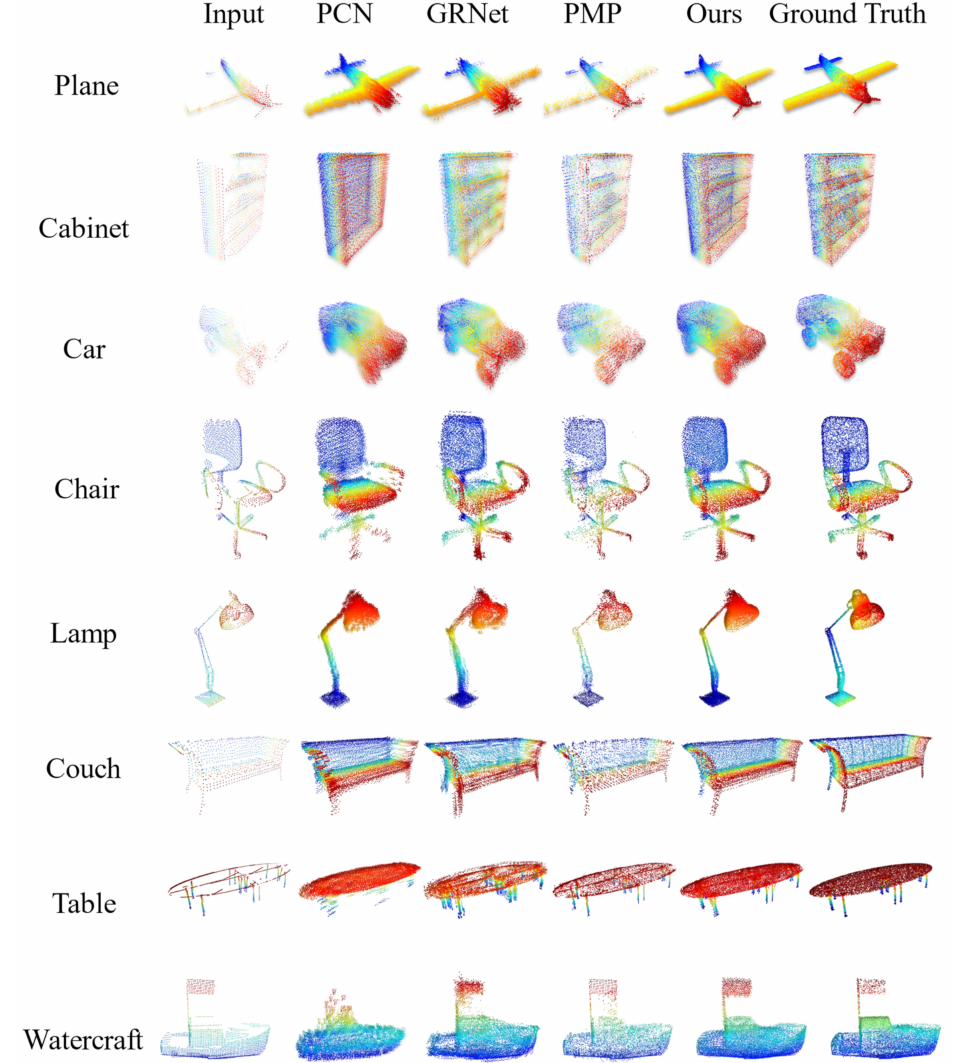
Figure 5. Comparison of visualization results on PCN dataset. Compared with other advanced algorithms, MAPGNet (Ours) has better visualization completion effect and can produce more accurate geometric structures and smoother surfaces. Ground Truth is the real complete point cloud corresponding to the